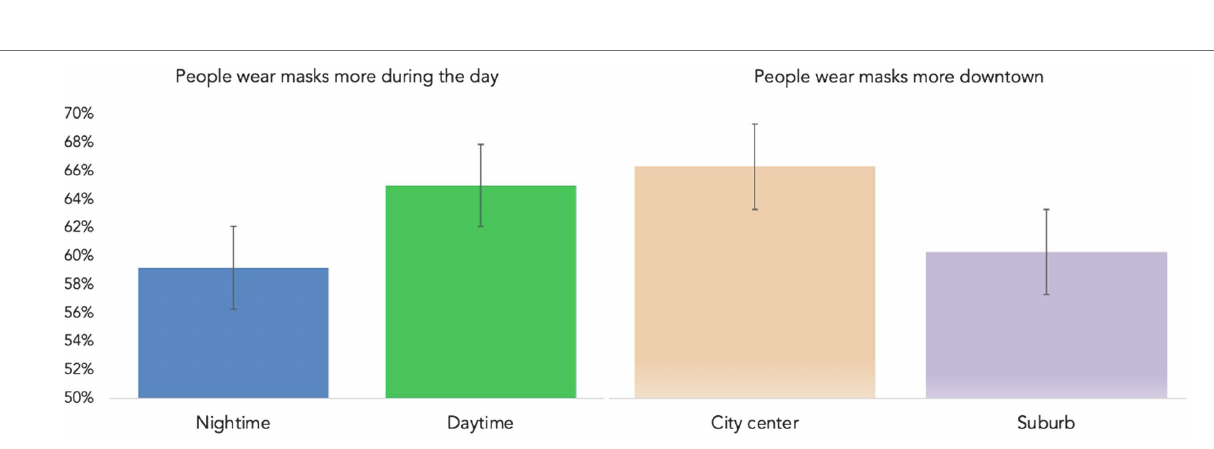
FIGURE 2 | People wore masks 69.2% when in areas where mask were required as opposed to 59.6% in areas where masks were not required (left) . Older people conformed more when mask was enforced, younger people wore the same amount of masks regardless of mask regulations (right)